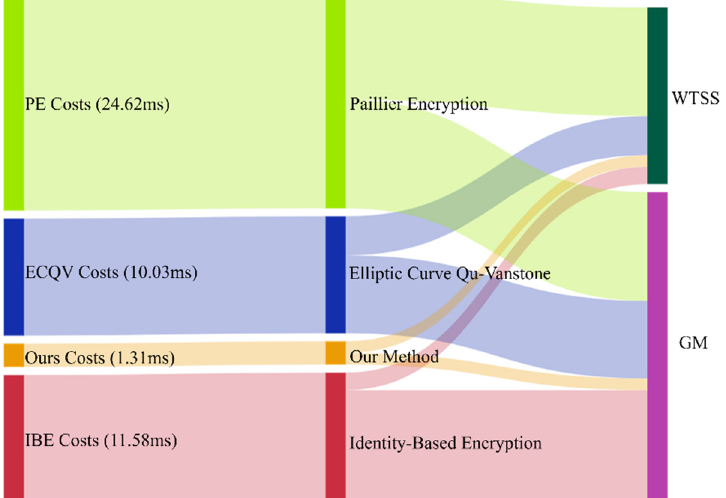
Figure 5. Computational cost comparison.